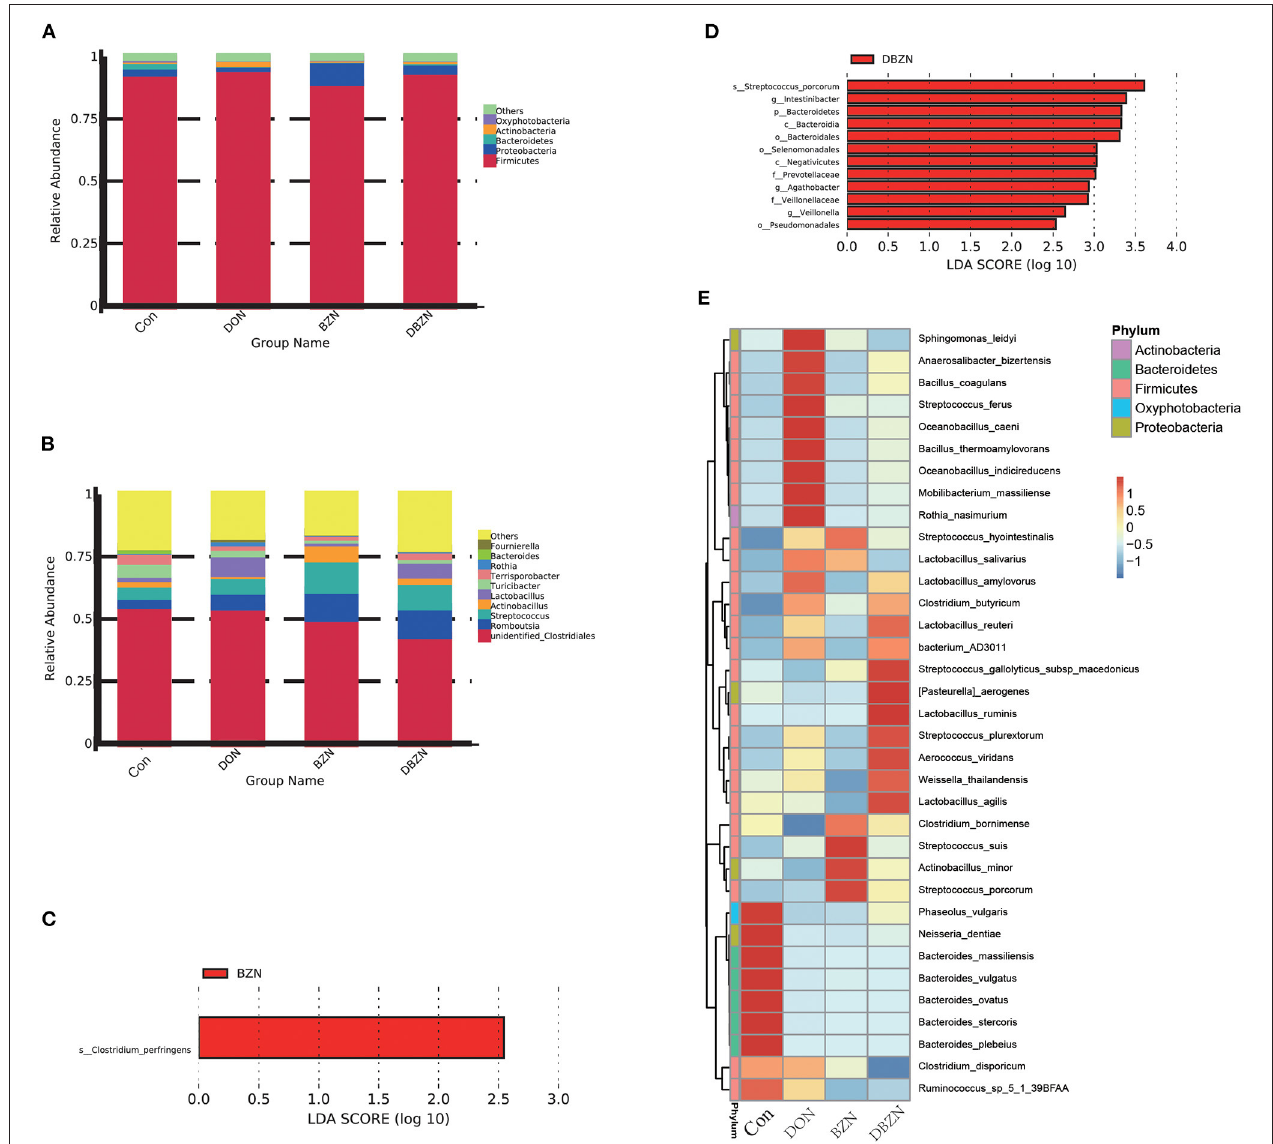
FIGURE 1 | Effects of BZN and DON on intestinal microbiome composition of piglet. (A) Intestinal microbiome composition at the phylum level. (B) Intestinal microbiome composition at the genus level. (C) The LEfSe analysis at different gut microbiota taxa between Con and BZN groups (LDA score > 2.5). (D) The LEfSe analysis at different gut microbiota taxa between DON and DBZN groups (LDA score > 2.5). (E) Heatmap showing significantly different species. Dietary treatment: Con, basal diet; DON, 4 mg/kg DON-contaminated diet; BZN, 0.5% BZN supplementation diet; DBZN, 0.5% BZN supplement in 4 mg/kg DON-contaminated diet. BZN, baicalin–zinc complex; Con, control; DON, deoxynivalenol; LDA, linear discriminant